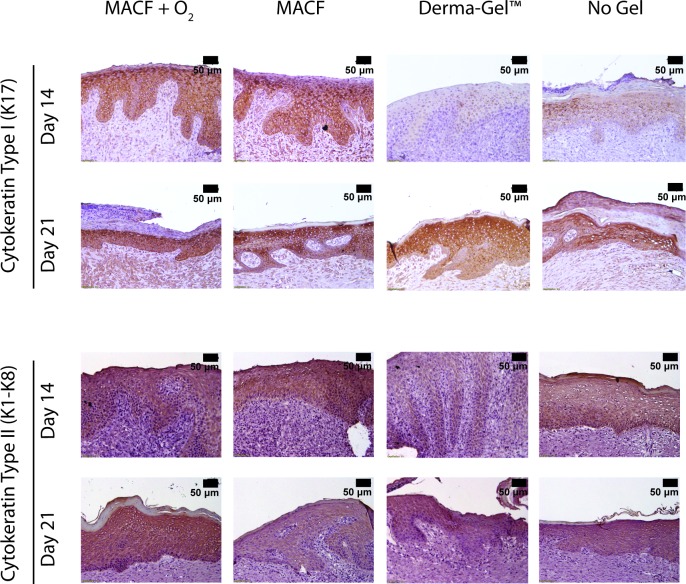
Cytokeratins Type I and II immunostaining shows MACF + O2 dressings may improve regulation of both cytokeratins suggesting regenerative epithelialization by the maturation of keratinocytes in later stages.Stained cells are dark brown in color. Representative images for all wound regions.